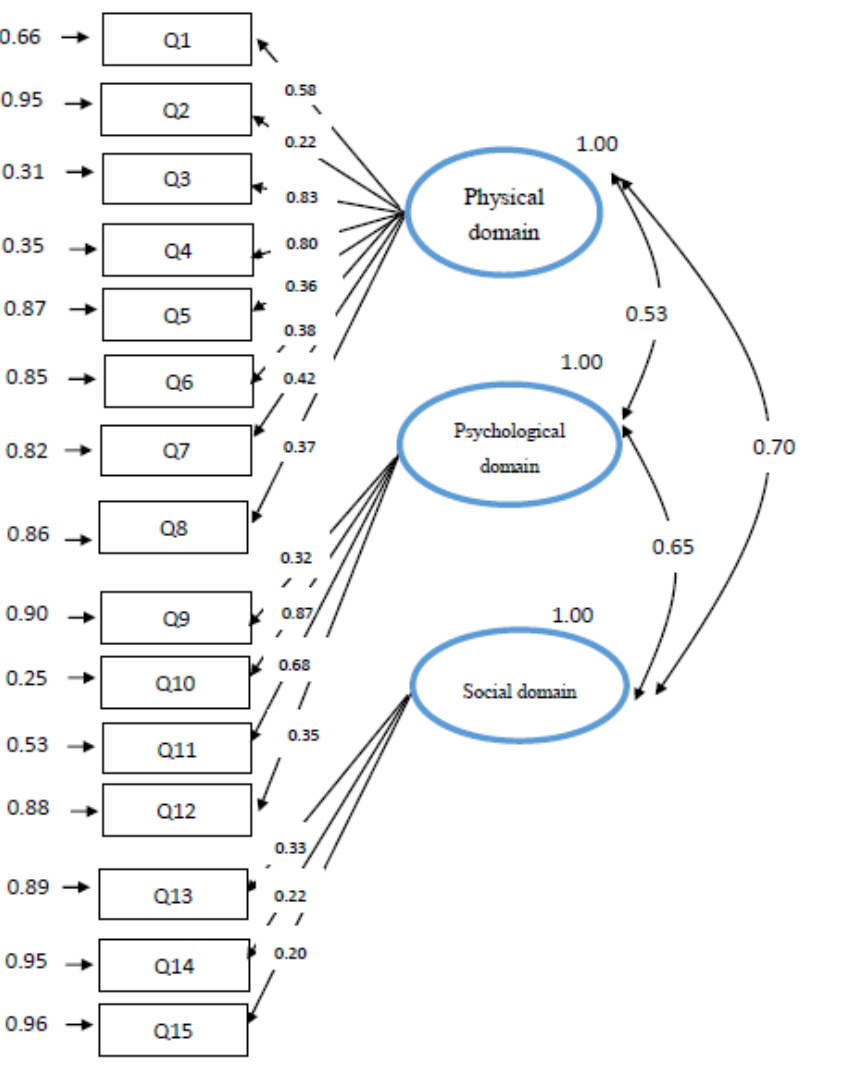
Figure 2. Final CFA model the TFI-T. Table 6. Analysis of the difference between the two groups of TFI-T ( N =